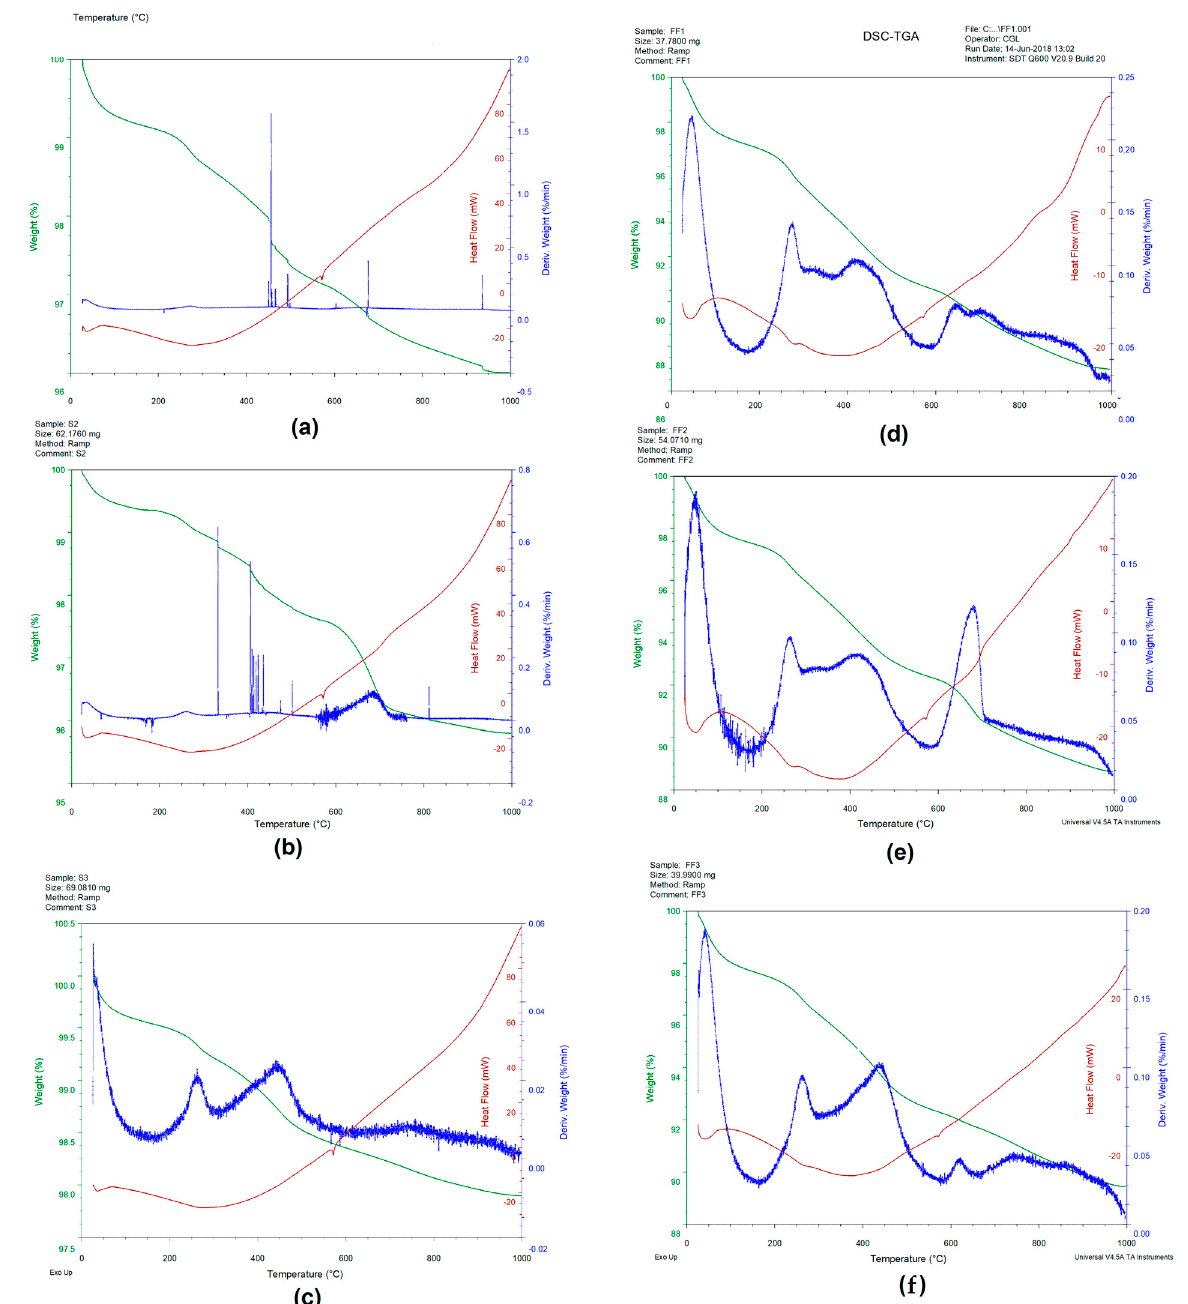
Figure 5. Thermal decomposition profiles of the R’mel soils: ( a–c ) represent the TGA/DSC curves for the complete fraction of Soils 1, 2, and 3, respectively. Images ( d–f ) represent the TGA/DSC curves for the fine fraction (<63 μ m) of Soils 1, 2, and 3 respectively.